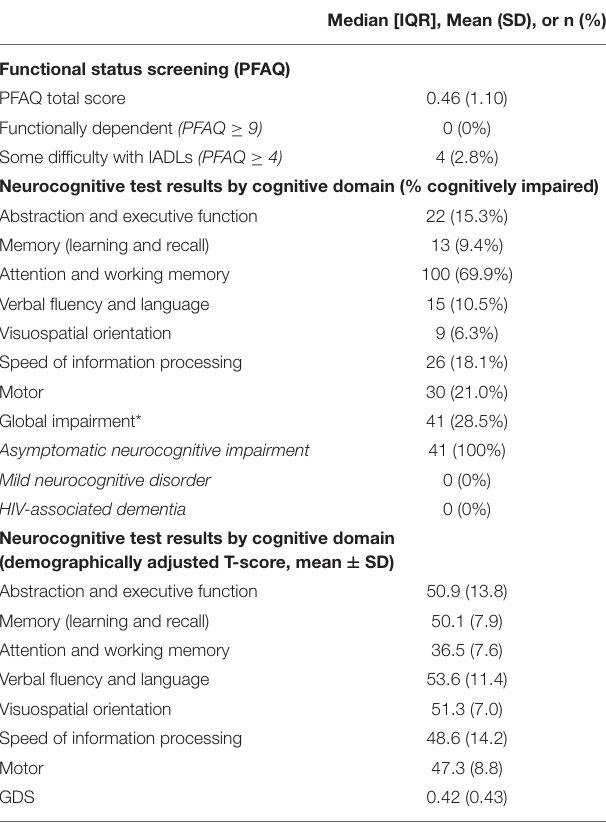
TABLE 3 | Neurocognitive and functional status screening results of PWH ( N = 144).